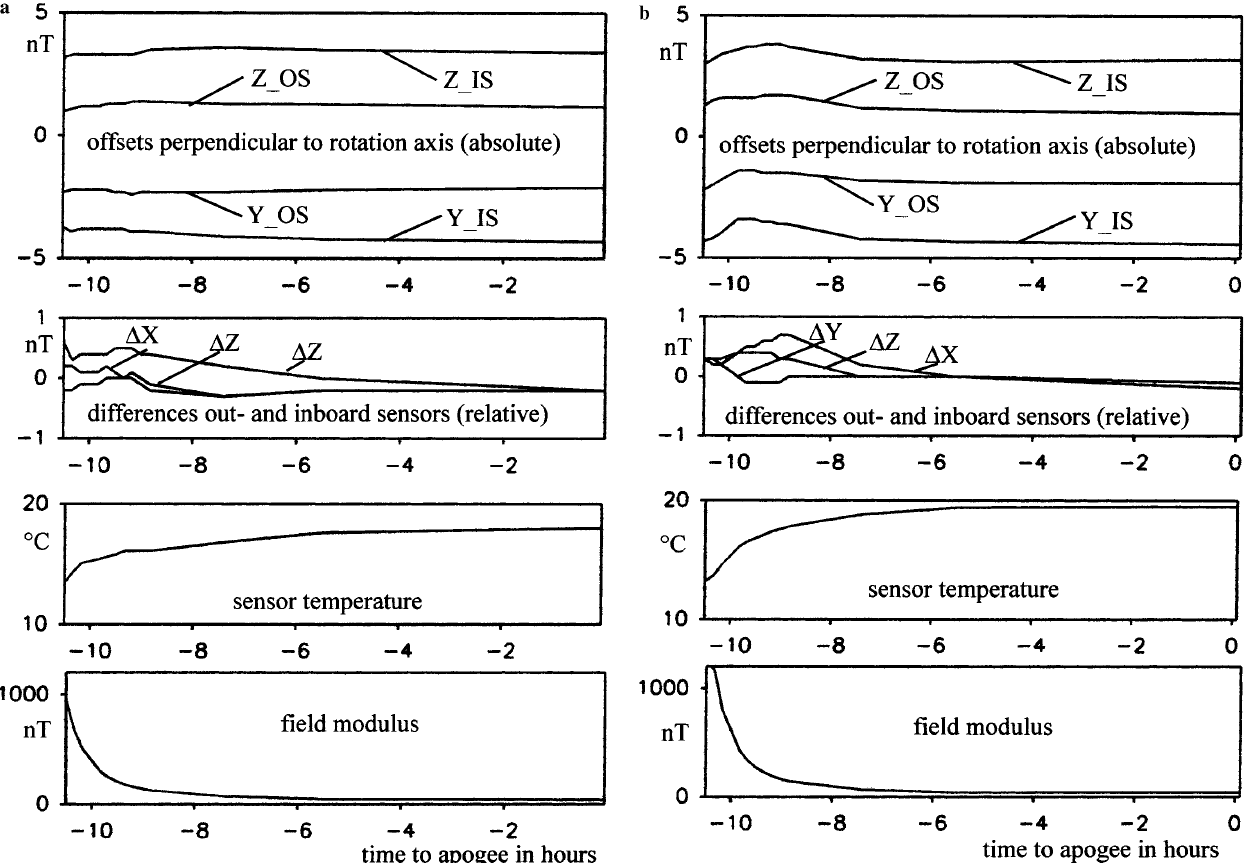
Fig. 5. a O(cid:128)set behaviour after perigee without torquing activities relative to apogee: b O(cid:128)set behaviour after torquing sequence relative to apogee (see text for